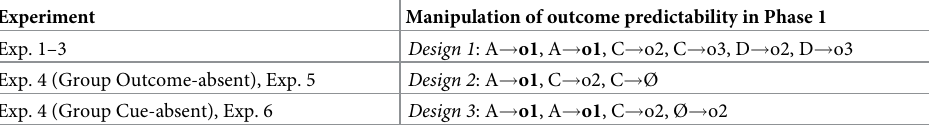
Table 1. Manipulations of outcome predictability in all